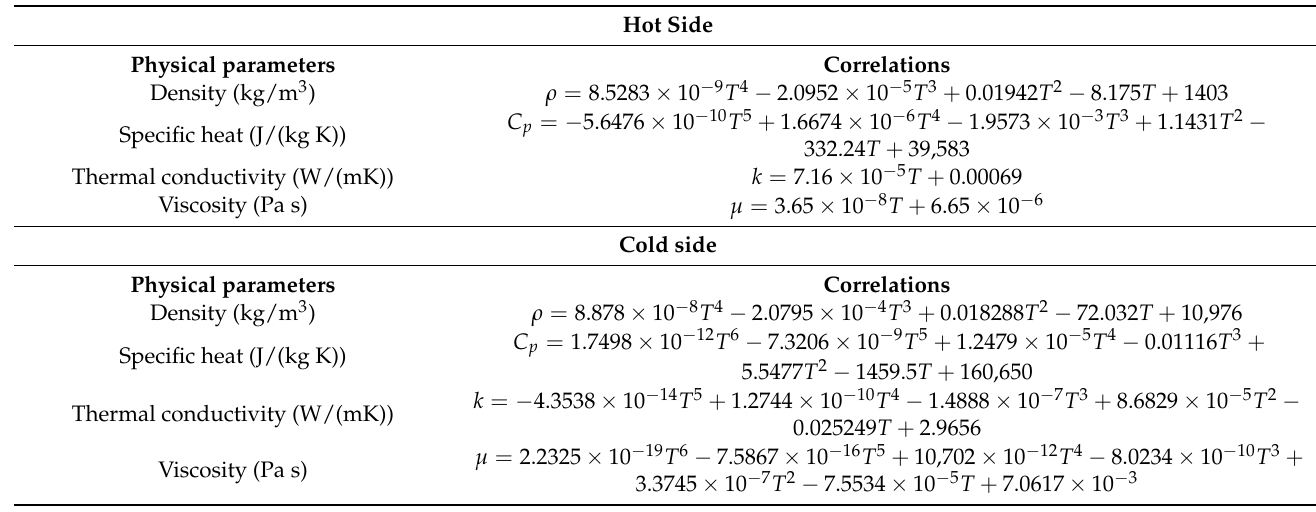
Table 4. The fitting correlations of both the hot and the cold